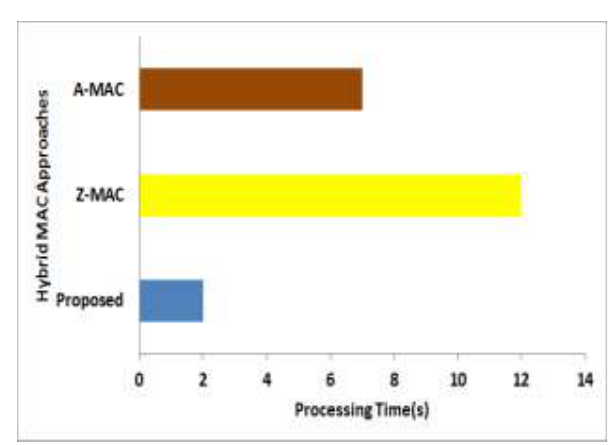
Figure 6 . Comparative Analysis of Processing Time. The proposed scheme takes only 2 seconds; the A-MAC scheme takes 7 seconds, while the Z- MAC scheme takes 12 seconds of algorithm processing time on a scale of 0-14